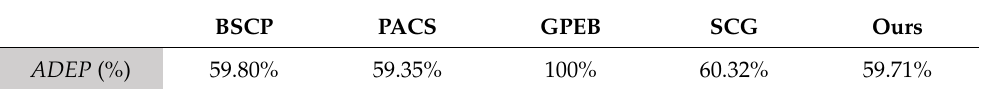
Table 6. Comparison of ADEP results of a 16-bit FWBM for various TEC schemes.